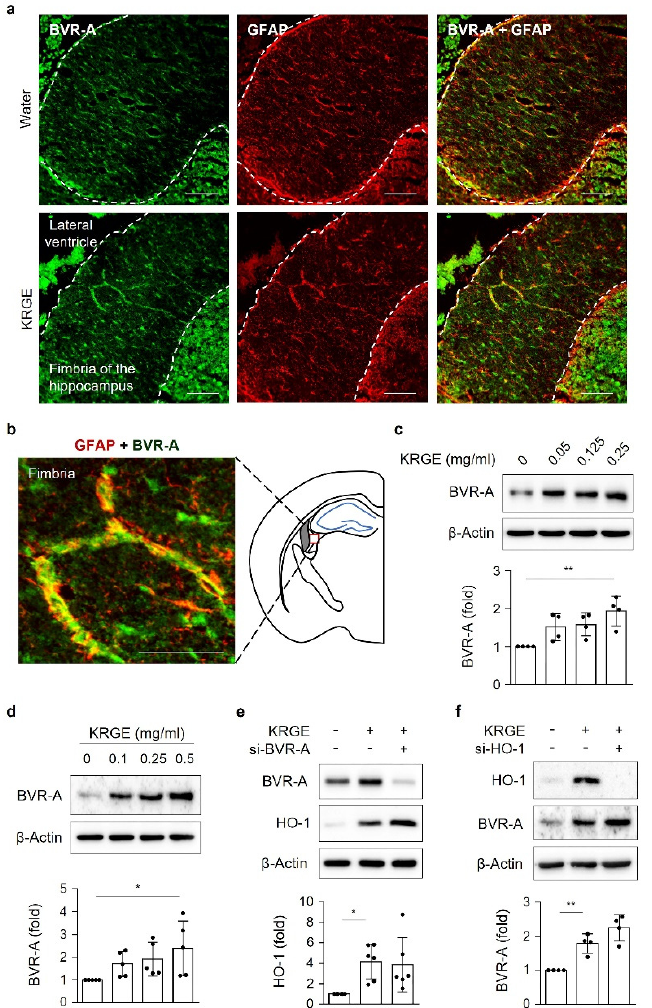
Figure 1. KRGE induces BVR-A and GFAP co-expression in the fimbria region of the mouse hippocampus. ( a ) Representative images of BVR-A (green) and GFAP (red) staining of mouse brains exposed to water or 0.25 mg/mL KRGE for 3 days ( n = 3 per group). Dotted lines indicate the area of hippocampal fimbria. Scale bar = 100 µm. ( b ) Co-localized staining can be observed as yellow color in the fimbria region of 0.25 mg/mL KRGE-treated mice. Scale bars = 50 µm. ( c ) The expression levels of BVR-A and β -actin proteins in the brain tissues were determined using Western blot analysis, and BVR-A levels were quantified ( n = 4 per group). ( d ) Astrocytes were incubated with KRGE at various concentrations for 24 h, and BVR-A levels were detected by Western blot analysis ( n = 5). ( e , f ) Astrocytes were transfected with control or the indicated siRNAs (i.e., si-BVR-A or si-HO-1) and subjected to 0.25 mg/mL KRGE for 24 h. HO-1 ( n = 6) or BVR-A ( n = 4) protein levels in cell lysates were detected via Western blotting. * p < 0.05; ** p < 0.01. BVR-A, biliverdin reductase A; GFAP, glial fibrillary acidic protein; HO-1, heme oxygenase 1; KRGE, Korean red ginseng extract; siRNA, small interfering RNA.